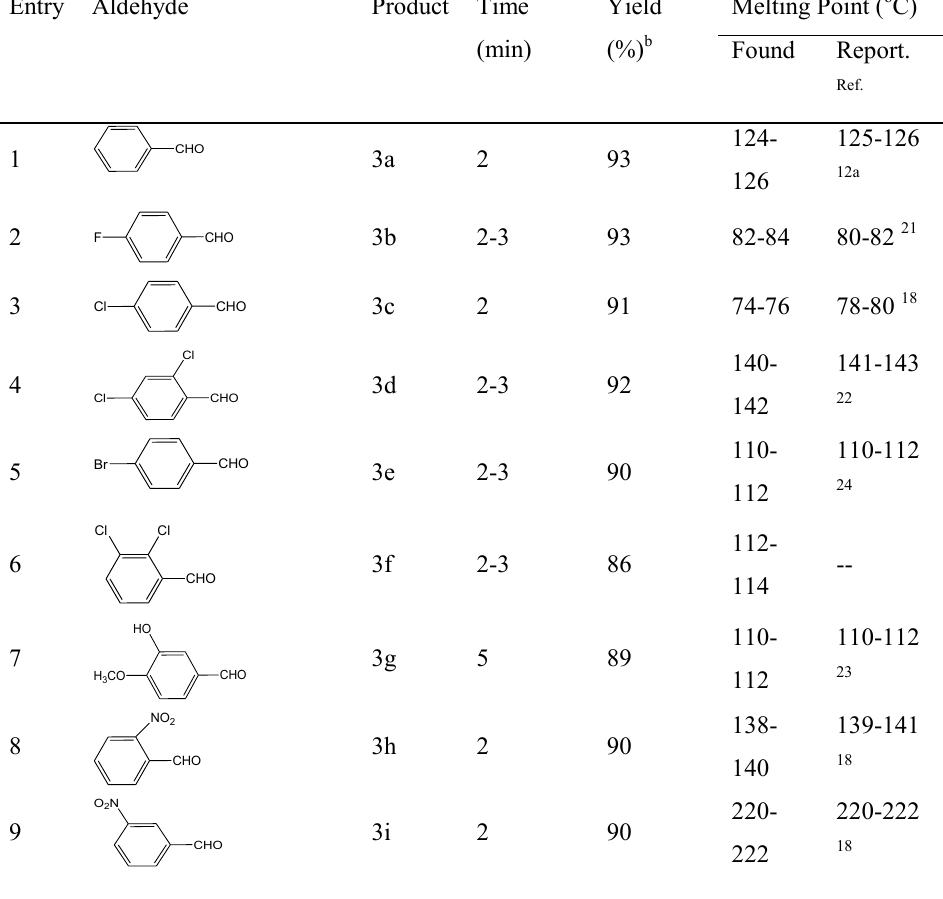
Table 3. Synthesis of Bis(indolyl)methanes( 3a-3q ) using Eaton’s reagent a . Entry Aldehyde Product Time